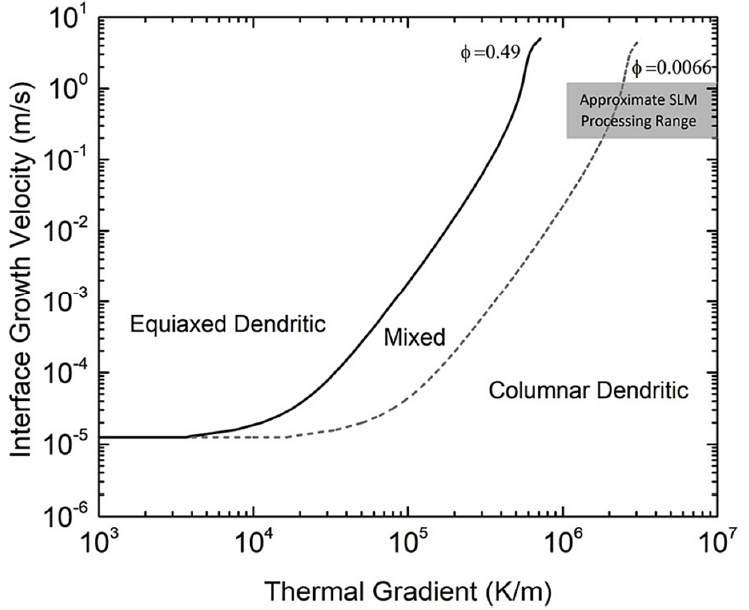
Figure 6. The G vs. R relationship that determines the microstructural morphology for the Al-10wt.%Si-0.5wt.%Mg alloy processed via the Selective Laser Melting (SLM) (i.e., L-PBF) route Reproduced from [39] with permission from Elsevier.